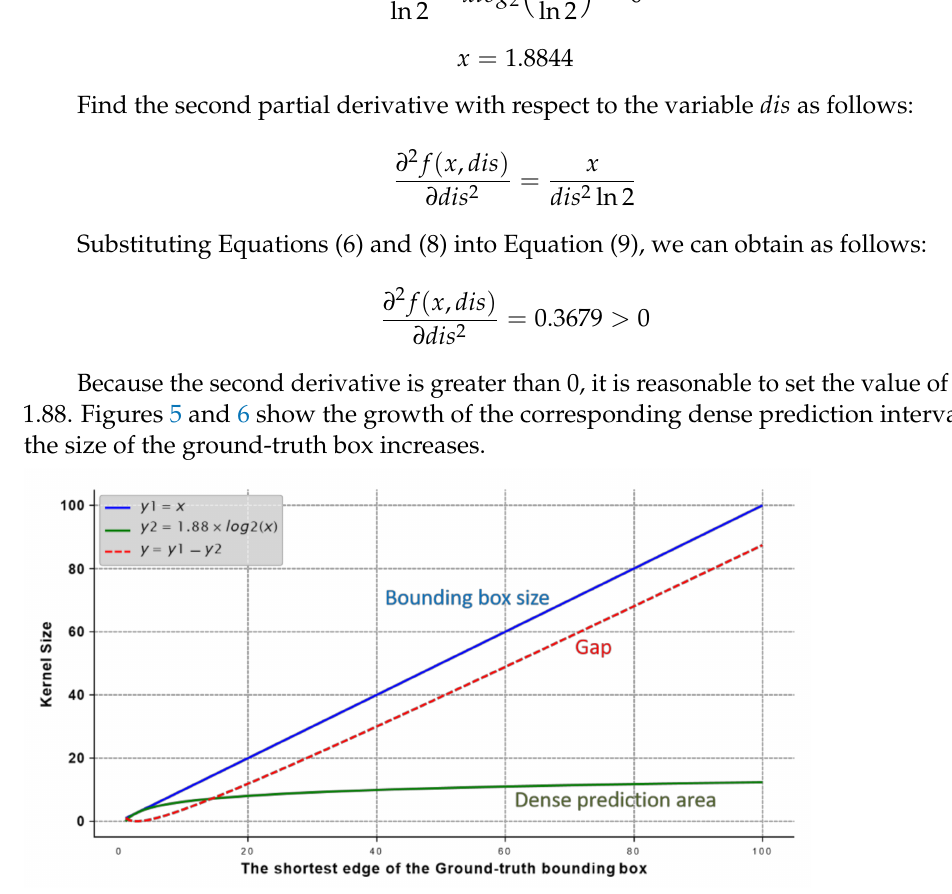
Figure 5. Schematic diagram of the growth of the proposed adaptive dense prediction function.